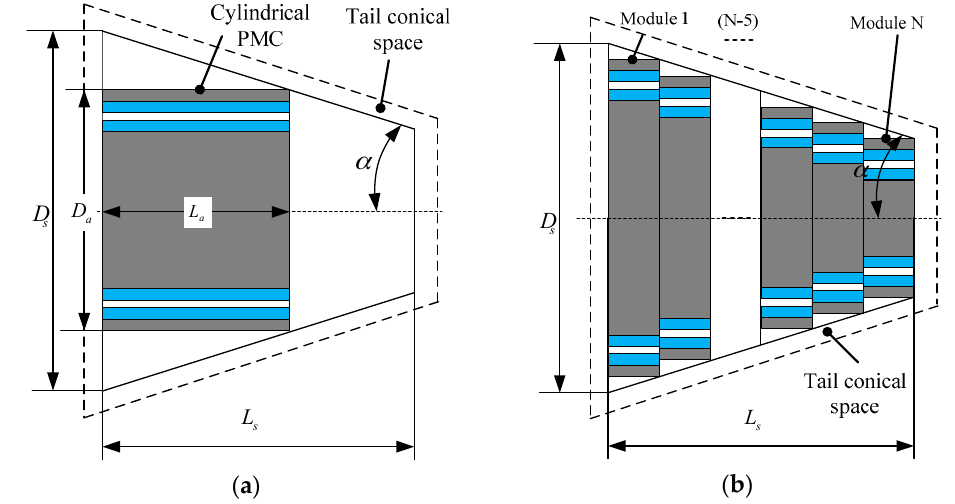
Figure 2. PMCs for underwater propulsion. ( a ) Structure of traditional cylindrical PMC. ( b ) Structure of the novel C-HPMC.